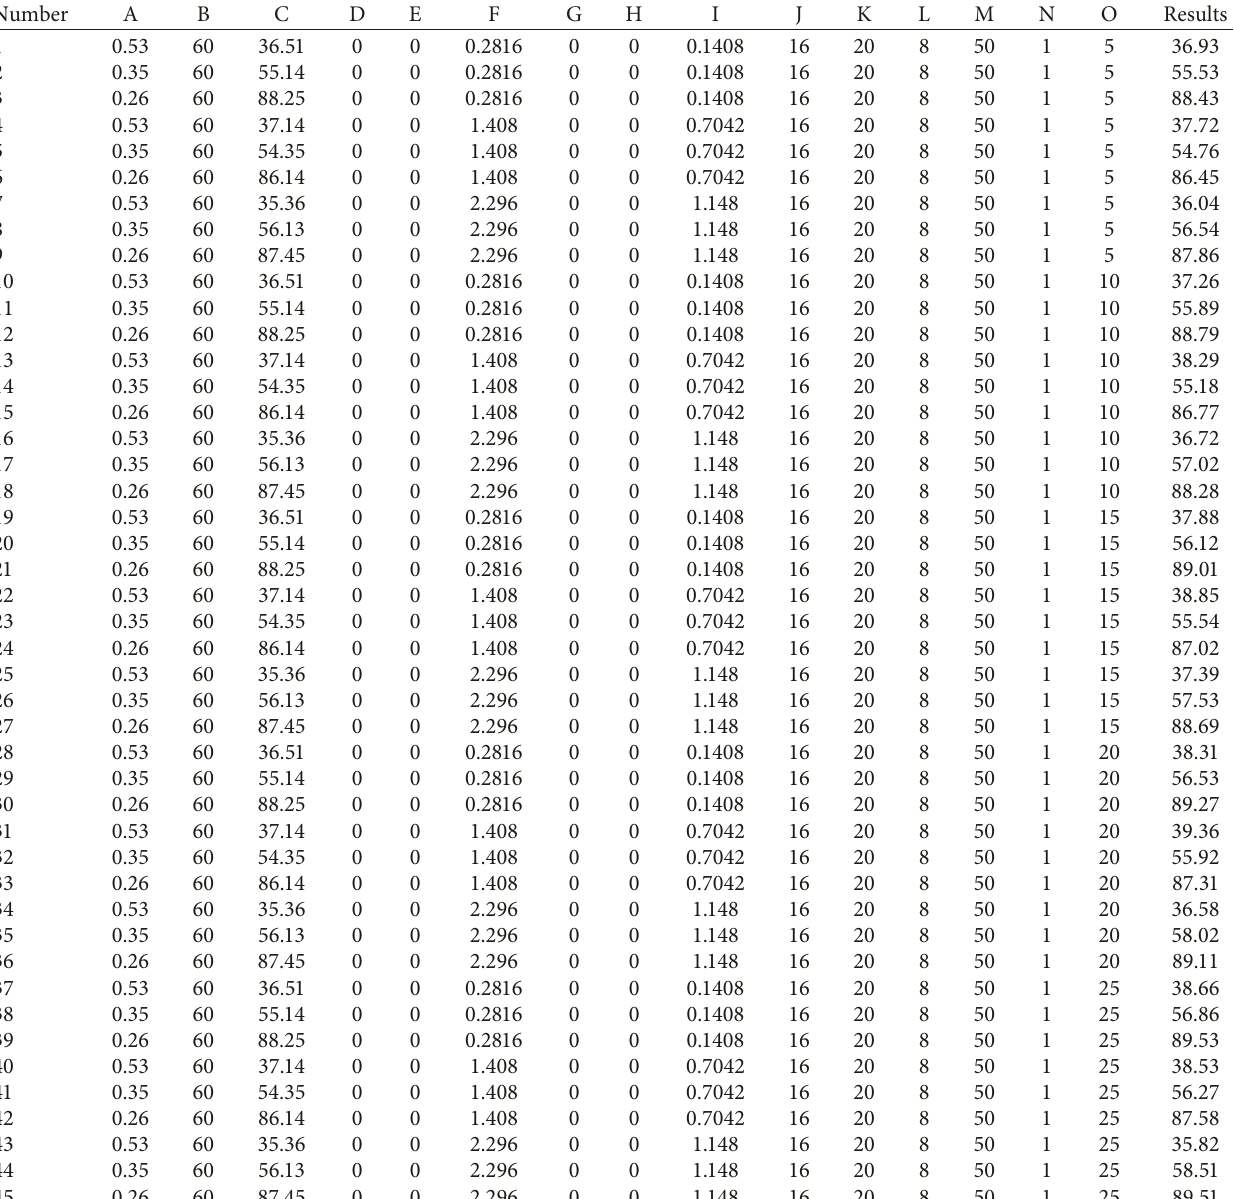
Table 8: Assemble list of influencing factors and